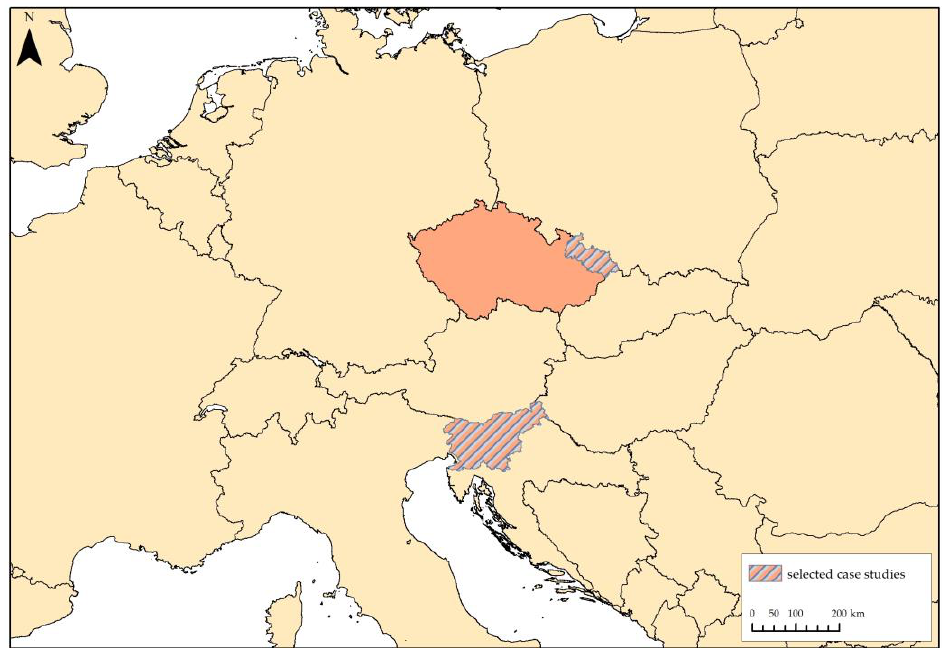
Figure 1. Map of both selected case studies—Slovenia and the Moravian-Silesian region (Czech Republic). Prepared by the authors [19].